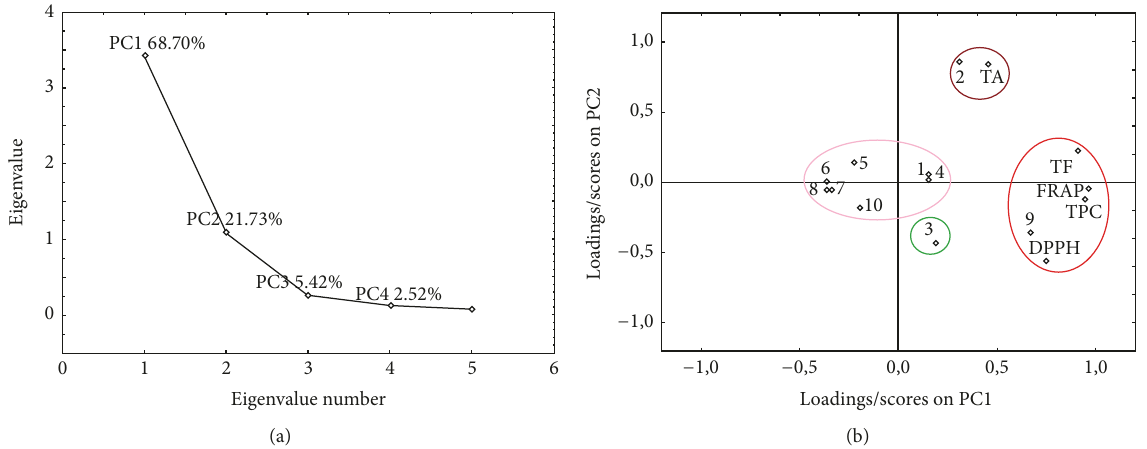
Figure 1: PC: principal component; (a) eigenvalue number; (b) loadings (variables)/scores (samples) biplot antioxidant analyses for the first and second PC of different parts of fruits: 1: S. cumini pulp; 2: S. cumini peel; 3: S. cumini seed; 4: S. nigrum pulp; 5: S. nigrum peel; 6: S. nigrum seed; 7: I. edulis pulp; 8: I. edulis seed; 9: H. dulcis pulp and peel; 10: H. dulcis seed.